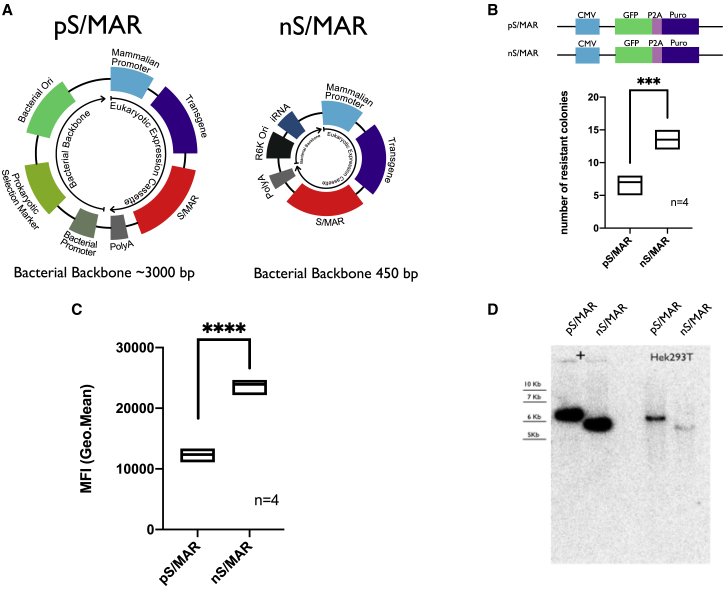
Nano-S/MAR Has Improved Establishment Efficiency, Sustains Higher Transgene Expression, and Is Maintained Episomally in the Nuclei of Target Cells(A) Schematic depiction of pS/MAR and nS/MAR DNA vectors. In nS/MAR vectors, the RNA-OUT R6K Ori system replaces the bacterial backbone comprising the bacterial origin of replication and the selection marker. (B) Number of colonies 35 days after GFP+ selection. In the plots the line represents the median of four independent replicates per group analyzed with the t test for significance (p = 0.0003). (C) nS/MAR vectors were shown to provide a more robust transgene expression in established cells when compared to the respective plasmid with the bacterial backbone (analyzed by t test p < 0.0001). (D) Southern blot showing the molecular integrity and the episomal maintenance of the vectors.